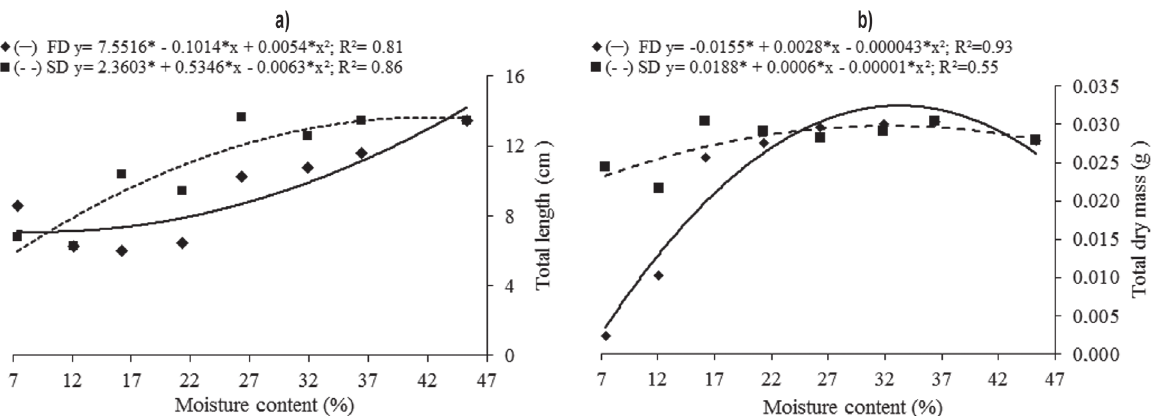
Figure 4 - Effect of drying rate on total length (cm) (a) and total dry mass seedlings (g) (b) of Campomanesia adamantium seedlings subjected to fast drying (FD) (silica) and slow drying (SD) (room temperature) at different water